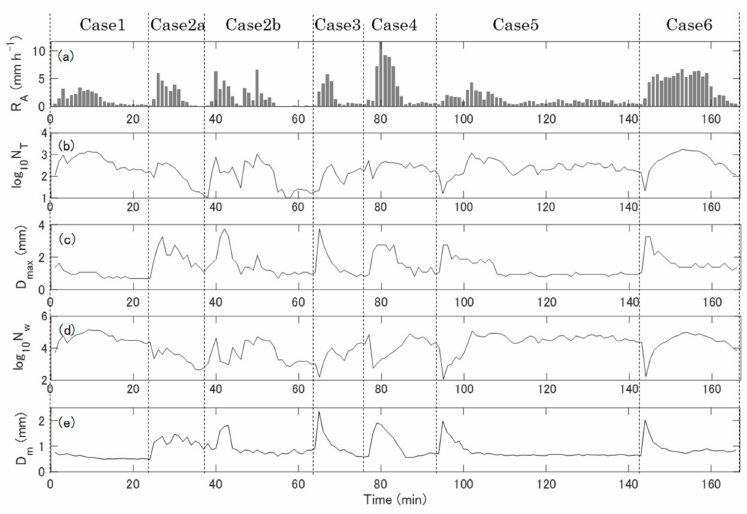
Figure 5. Temporal changes in gamma PSD parameters observed by Parsivel 2 during eruption 6 (16 July 2018). ( a ) Ash fall rate R A . ( b ) Total number of volcanic ash particles N T . ( c ) Maximum diameter